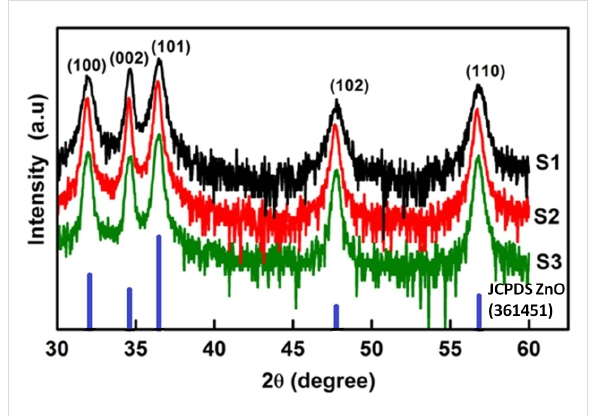
Figure 1: XRD patterns of samples S1, S2 and S3 in log scale indexed to the hexagonal wurtzite structure of ZnO. The standard JCPDS data for ZnO is also shown for